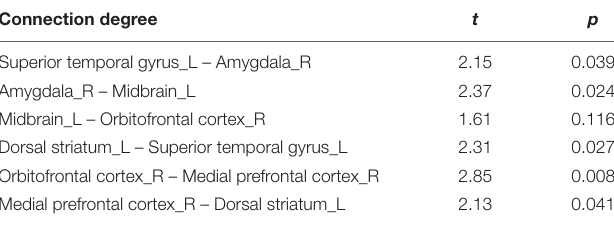
Table 4 | The connection difference between the superior temporal gyrus and the reward system of different musicians when listening to music with Western style. Connection